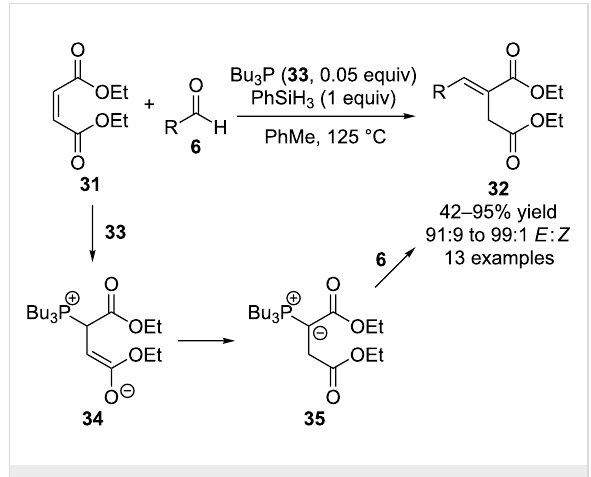
Scheme 9: Base-free catalytic Wittig reactions reported by